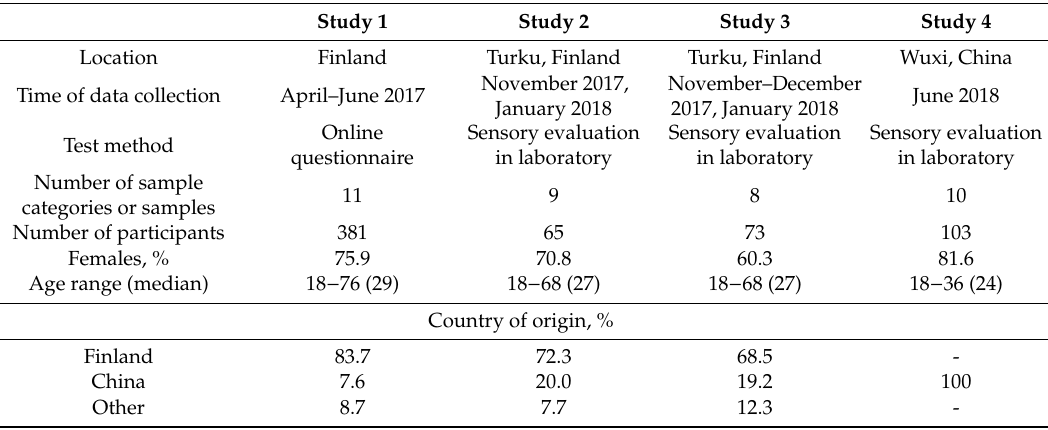
Table 1. Characteristics of the four studies conducted. Study 1 Study 2 Study